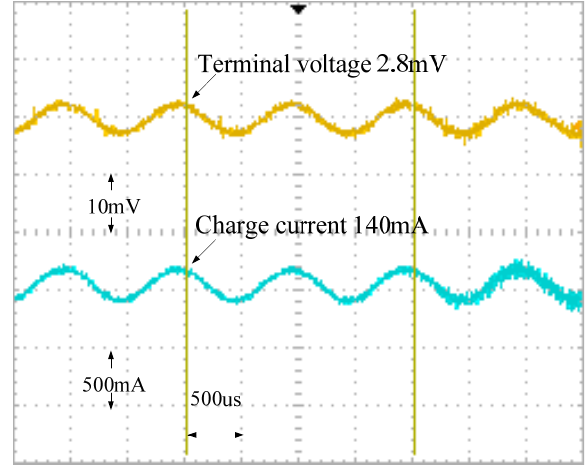
Figure 17. The charge current and the terminal voltage waveforms with DC components filtered at an SOC of